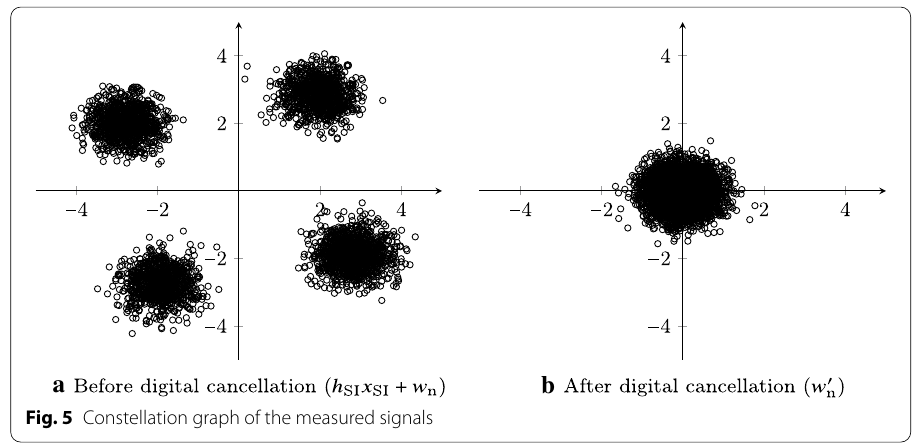
Fig. 5 Constellation graph of the measured signals